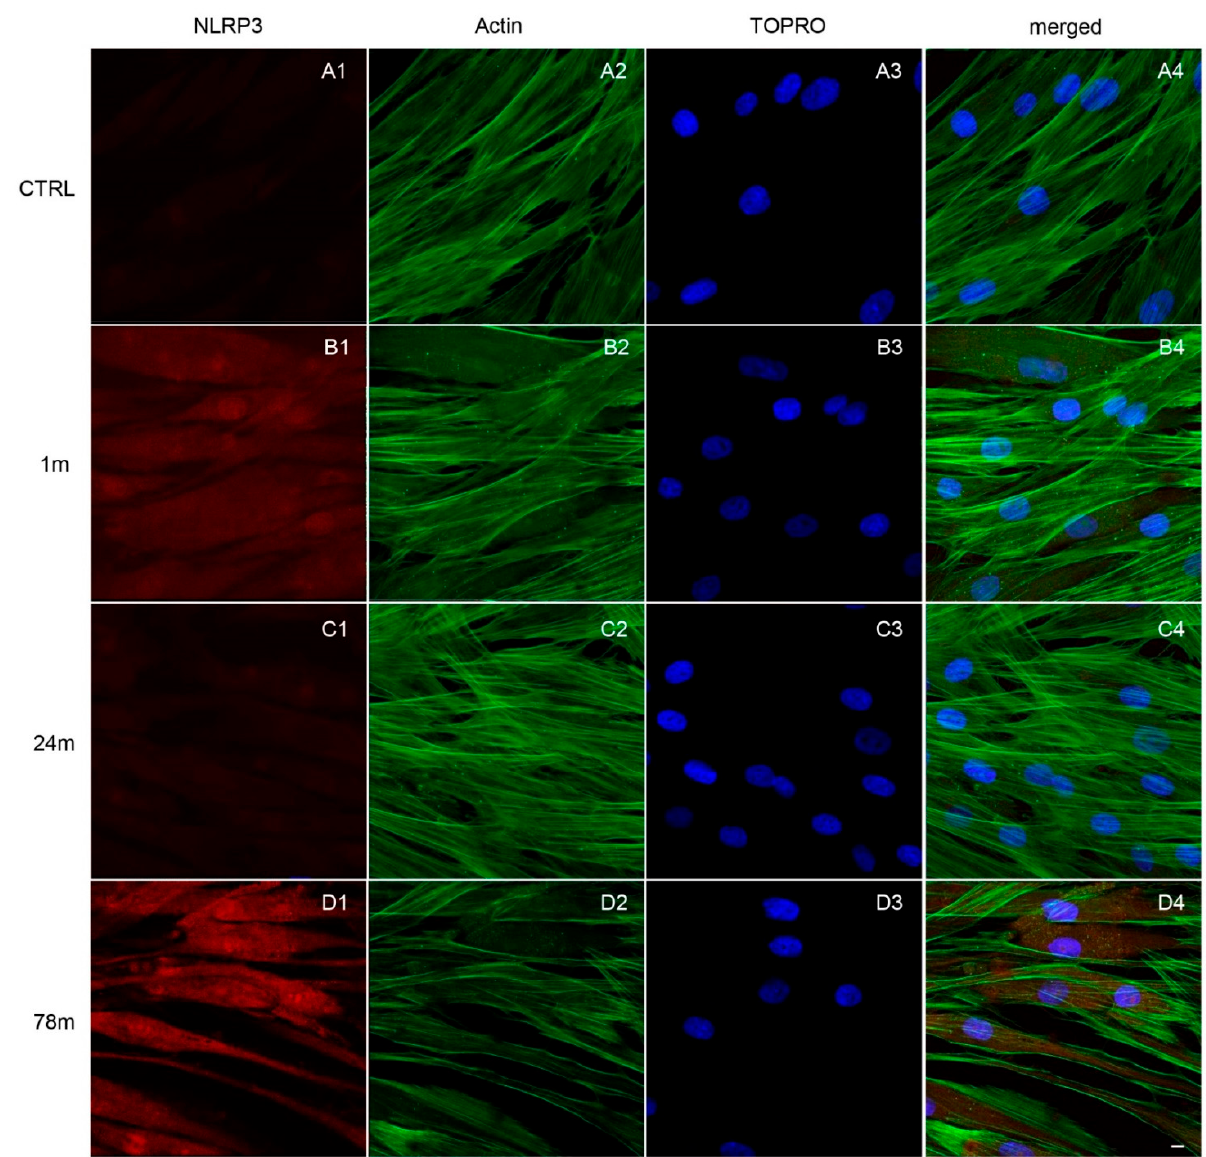
Figure 6. Immunofluorescence analysis of NLRP3 expression on ( A1 ) CTRL cells and on cells exposed to ( B1 ) 1, ( C1 ) 24 and ( D1 ) 78 m MPs. ( A1 – D1 ) Red fluorescence: NLRP3; ( A2 – D2 ) green fluorescence: cytoskeleton actin; ( A3 – D3 ) blue fluorescence: cell nuclei; ( A4 – D4 ) merged image of the above mentioned channels. Scale bar: 20 μ m.